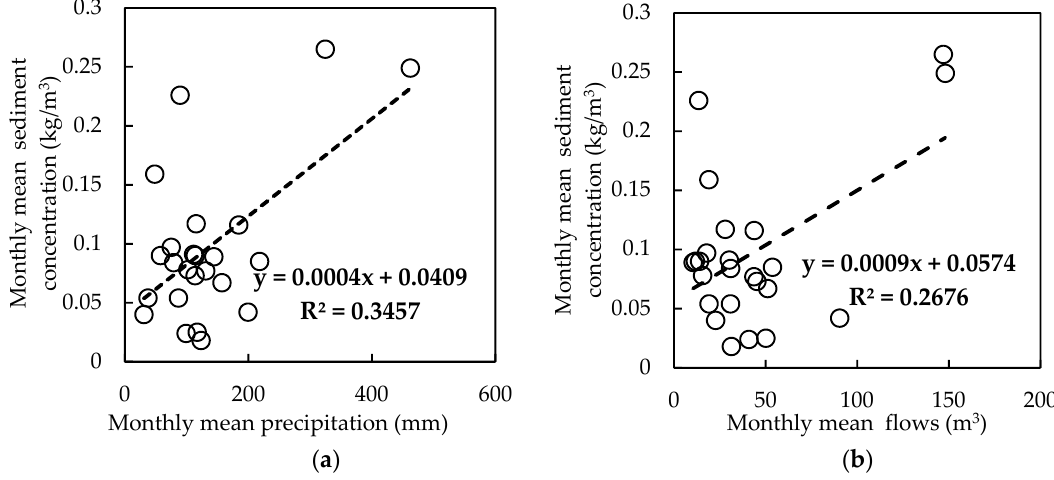
Figure 12. The relationship between the mean monthly sediment concentration and the mean monthly precipitation ( a ) and the relationship between the mean monthly sediment concentration and the mean monthly flows ( b ).